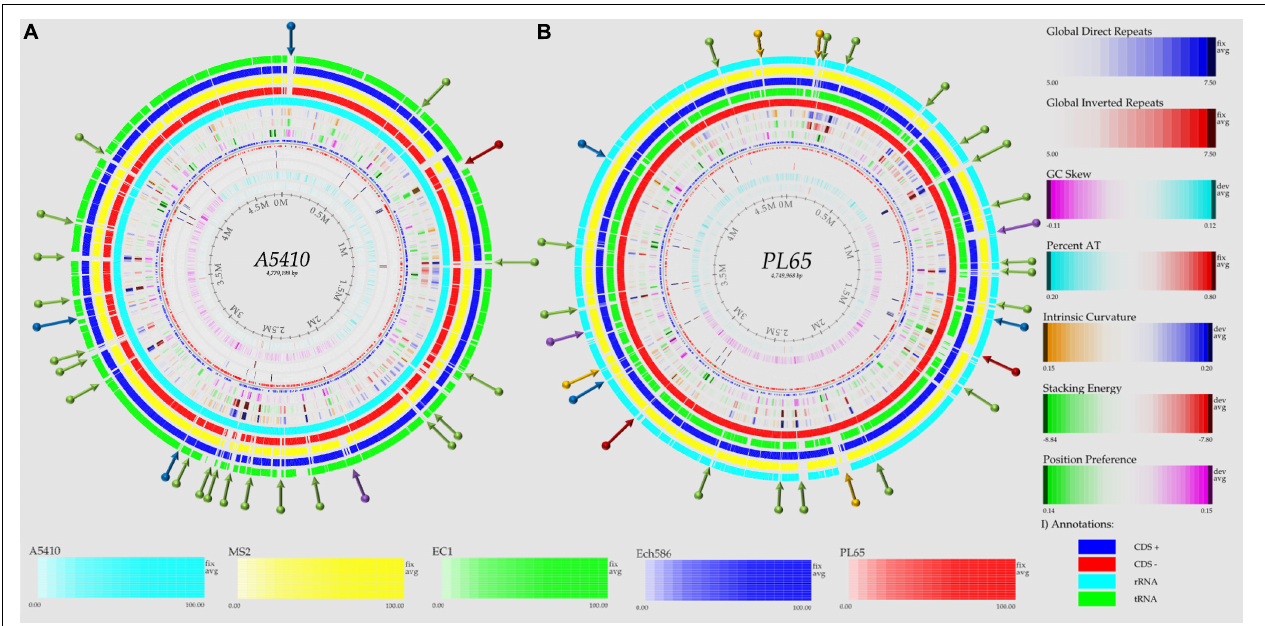
FIGURE 5 | Genome BLAST atlases within the D. zeae complex species. The genomes of novel strains (A) A5410 and (B) PL65 were used as references to generate the circular graphics. Data of DNA, RNA, and gene features of both the references were obtained after annotating the genomes using the NCBI prokaryotic genome annotation pipeline (PGAP). From the most inward lane, the figures display the size of the genome (axis), percent AT (red = high AT), GC skew (blue = most Gs), inverted and direct repeats (DRs; color = repeat), a position preference, stacking energy, and an intrinsic curvature. Following these layers, the external solid rings (indicated with a unique color) represent the genomes of other D. zeae strains mapped against the references. Olive arrows highlight those unique DNA regions associated with a high intrinsic curvature, stacking energy and a position reference found solely in the novel strains A5410 and PL65. Dark-red arrows pinpoint the areas of the genome with a low intrinsic curvature, stacking energy, and a position reference. Dark-blue arrows indicate a low intrinsic curvature and low stacking energy but a high position reference. Orange arrows show areas of the genome displaying a high intrinsic curvature and high stacking energy but a low position reference, whereas purple arrows represent those genetic zones absent in some D. zeae isolates. BLAST genome atlases were created using the CMG-biotools